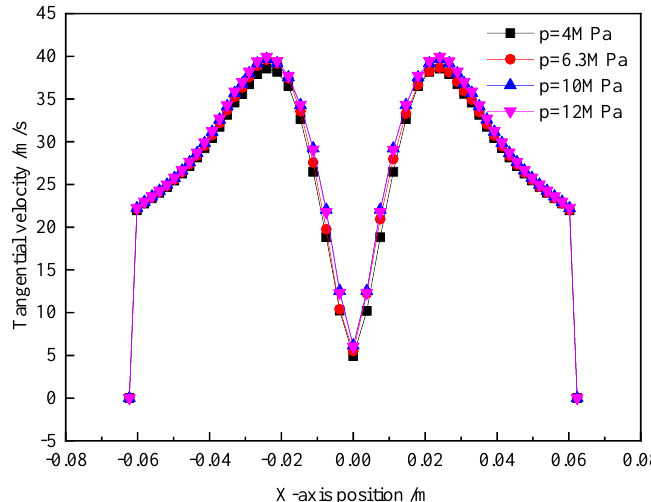
Figure 6. Tangential velocity profiles at z = − 500 mm section ( v in = 8